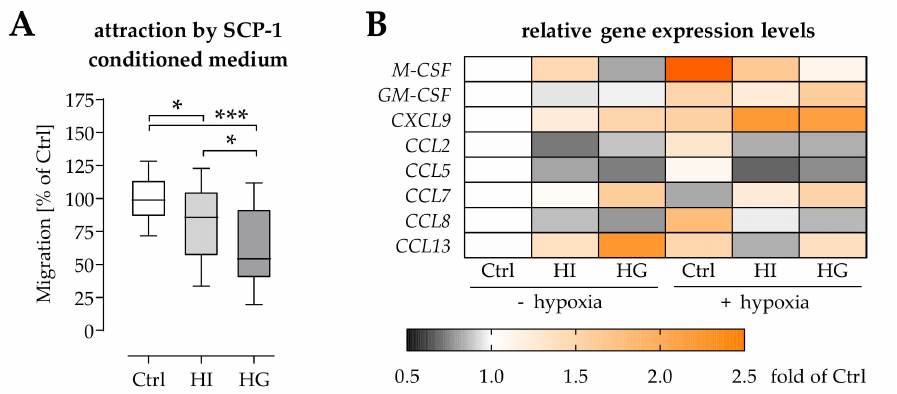
Figure 3. Diabetic conditions affect expression and secretion of factors in SCP-1 cells required to attract THP-1 cells. ( A ) SCP-1 cells were cultured under normoglycemic (Ctrl), hyperinsulinemic (HI), or hyperglycemic (HG) conditions for 48 h to obtain SCP-1 cell conditioned media. Migration of THP-1 cells towards these SCP-1 cell conditioned media was determined by Boyden chamber migration assay. Data are presented as box plot. Data were compared by non-parametric Kruskal- Wallis test, followed by Dunn’s multiple comparison test. * p < 0.05 and *** p < 0.0001 as indicated. N = 4 and n = 4. ( B ) After 24 h in the presence or absence of hypoxia, relative gene expression levels of M-CSF , GM-CSF , CXCL9 , CCL2 , CCL5 , CCL7 , CCL8 , and CCL13 in the conditioned SCP-1 cells were determined by semiquantitative RT-PCR. Amplicons were seperated twice by electrophoresis, to minimize loading errors. Signal intensities were quantified using the ImageJ software (NIH, Bethesda, MD, USA) and normalized to the control group. Mean data (N = 4, n = 2) are presented as heat map. 2.4. Hyperglycemia Affected Chemoattraction of Mononuclear Cells by MCP-1 and MCP-2 As hypoxia failed to increase gene expression of CCL2 (encoding MCP-1) and CCL8 (encoding MCP-2) under pre-/diabetic conditions (Figure 3B), corresponding chemokines levels were determined in serum of newly diagnosed type 2 diabetics and respective controls. Both MCP-1 and MCP-2 serum levels were significantly reduced in diabetics, when compared to the controls (Figure 4A).